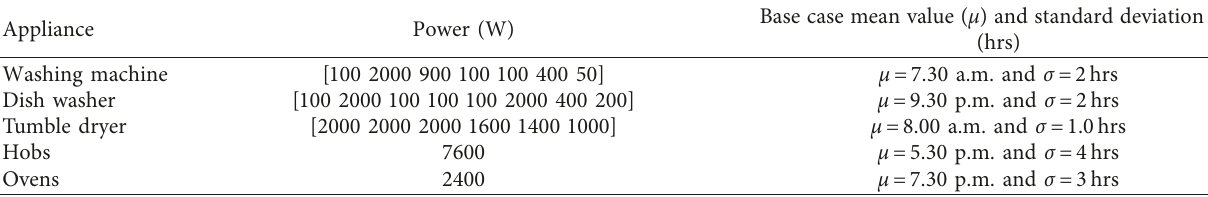
Algorithm 2 for case study 1 was obtained using the opti- mization algorithm. The algorithm parameters used are 64 chromosomes and 5000 iterations for the study.